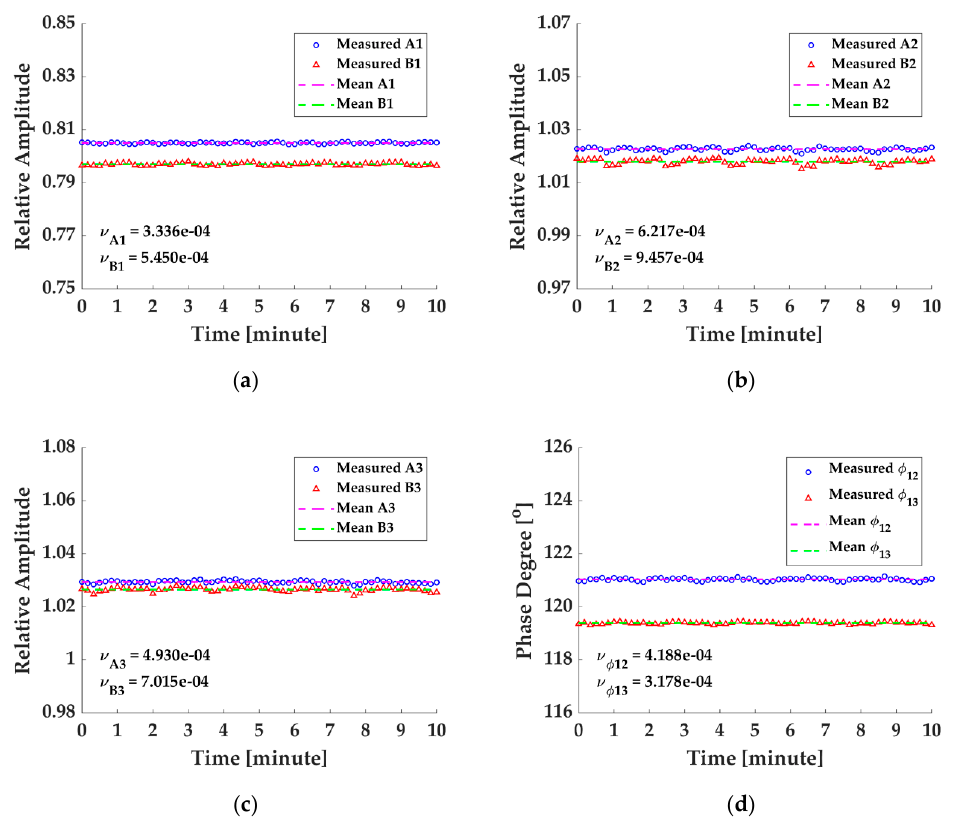
Figure 9. Stability of the calibrated parameters in the 10-min test: ( a ) the relative amplitude of the calibrated parameters A 1 , B 1 and their mean values; ( b ) the relative amplitude of the calibrated parameters A 2 , B 2 and their mean values; ( c ) the relative amplitude of the calibrated parameters A 3 , B 3 and their mean values; ( d ) the magnitudes of the calibrated phase degree parameters and their mean values.